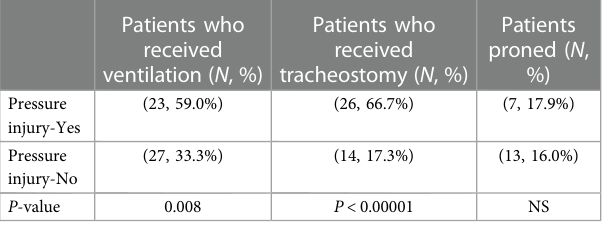
TABLE 3 Ventilation, tracheostomy, and proning in the ICU of COVID-19 patients±pressure injuries. Patients who